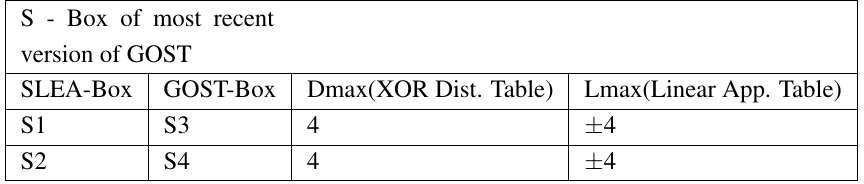
Table 5. Summaryof the non-linear properties of GOST block cipher